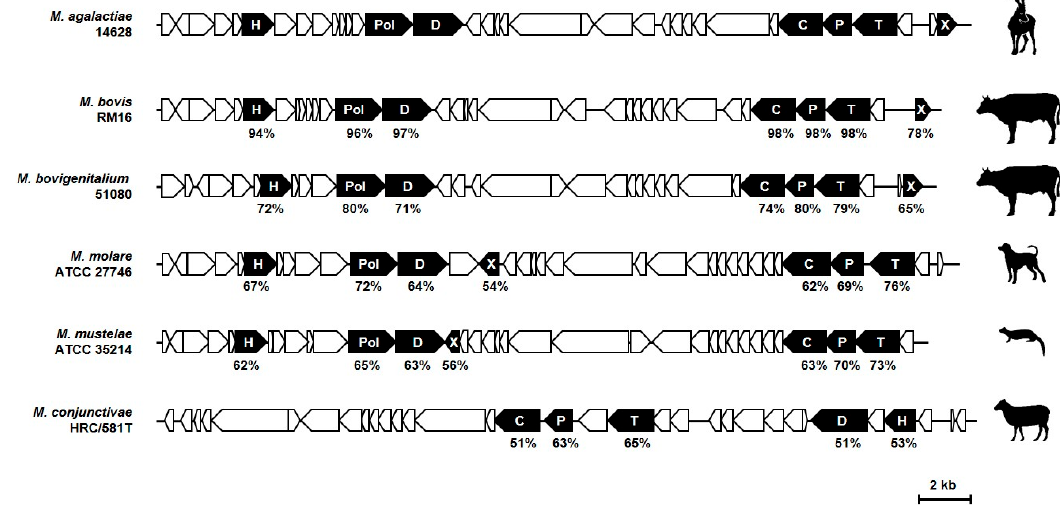
Figure 5. Genome map of M. agalactiae ϕ MAgV1 from strain 14628 and comparison with MAgV1-like sequences identified in Mycoplasma species of the Hominis phylogenetic group. The locations, sizes, and orientations of the CDSs are indicated by arrows. MAgV1-like sequences were identified by BLASTP analyses using ϕ MAgV1 CDSs highlighted in black and a sequence database consisting of non-redundant protein sequences restricted to Mollicutes (taxid:31969). No similarity was identified outside of the Hominis phylogenetic group. The letter code in black arrows refers to CDS products: H, helicase; Pol, DNA polymerase; D, DNA primase; C, prohead protein; P, portal; T, terminase; X, Xer. For each CDS, the percentage of the global similarity with ϕ MAgV1 is indicated. This value was determined by using the EMBOSS Needle alignment tool. Animal icons are used to illustrate the host tropism of each strain. The overall organization of ϕ MAgV1 is conserved in M. bovis RM16 and M. bovigenitalium 51080. A particular feature of MAgV1-like sequences in M. molare ATCC 27746 and M. mustelae ATCC 35214 is the central position of the recombinase gene ( xer ). The genome of M. conjunctivae HRC / 581T is characterized by an important reorganization of the MAgV1-like sequence and the absence of DNA polymerase and recombinase genes.